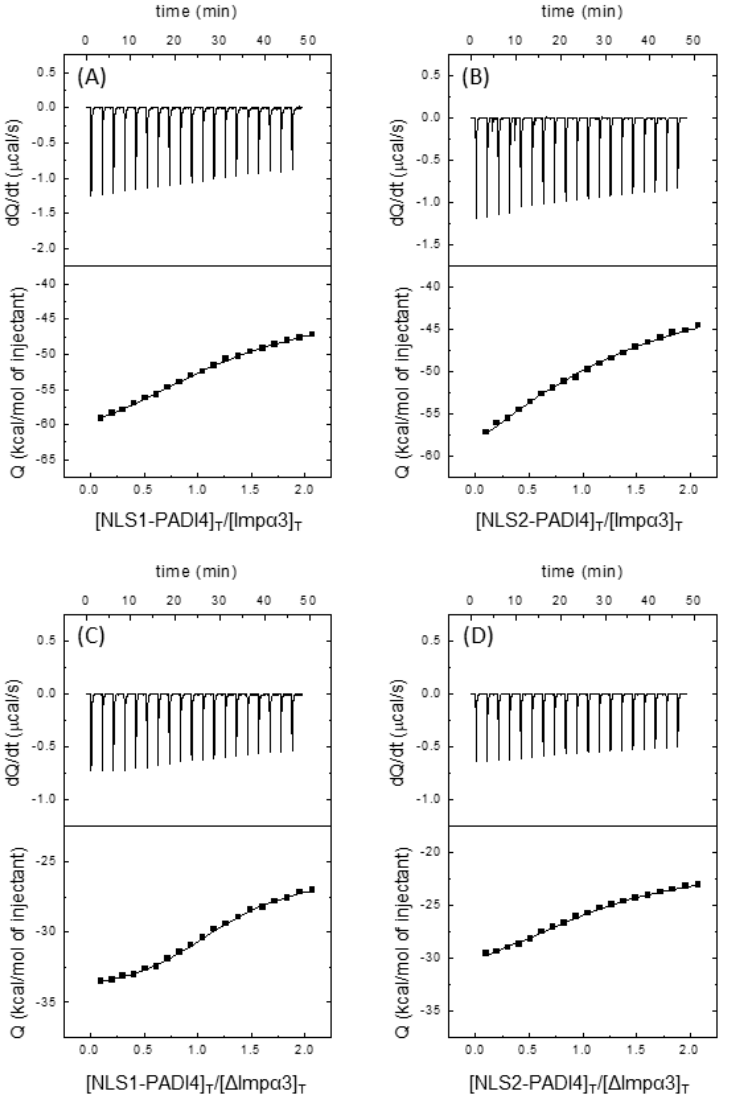
Figure 6. Binding of importin species to NLS1-PADI4 and NLS2-PADI4 as monitored by ITC. Calorimetric titrations for the NLS peptides binding to importin species. Imp α 3 interacting with ( A ) NLS1-PADI4 and ( B ) NLS2-PADI4, and ∆ Imp α 3 interacting with ( C ) NLS1-PADI4 and ( D ) NLS2-PADI4. Upper panels show the thermograms (thermal power as a function of time), and lower panels show the binding isotherms (ligand-normalized heat effects per injection as a function of the molar ratio in the calorimetric cell). Continuous lines correspond to the fitting curves according to a single ligand binding site interaction model. Experiments were carried out at 25 ◦ C. The results from BLI (Figure S4) yielded values of the dissociation constants different from those measured for ITC. For NLS1-PADI4, the K d values were 18 ± 4 µ M (for Imp α 3), with k on = 0.0037 ± 0.0002 µ M − 1 · s − 1 and k off = 0.0685 ± 0.0007 s − 1 (Figure 7A), and 4 ± 1 µ M (for ∆ Imp α 3), with k on = 0.011 ± 0.002 µ M − 1 · s − 1 and k off = 0.046 ± 0.005 s − 1 (Figure 7B). On the other hand, for NLS2-PADI4, the values of the dissociation constants and kinetic rates were 99 ± 10 µ M (for Imp α 3), with k on = 0.003 ± 0.002 µ M − 1 · s − 1 and k off = 0.32 ± 0.01 s − 1 (Figure 8A), and 12 ± 4 µ M (for ∆ Imp α 3), with k on = 0.020 ± 0.003 µ M − 1 · s − 1 and k off = 0.23 ± 0.01 s − 1 . Therefore, from the kinetic point of view, we can conclude that (i) both peptides had an affinity for ∆ Imp α 3 higher than that for Imp α 3 (i.e., the dissoci- ation equilibrium constant for ∆ Imp α 3 was smaller than for Imp α 3), in agreement